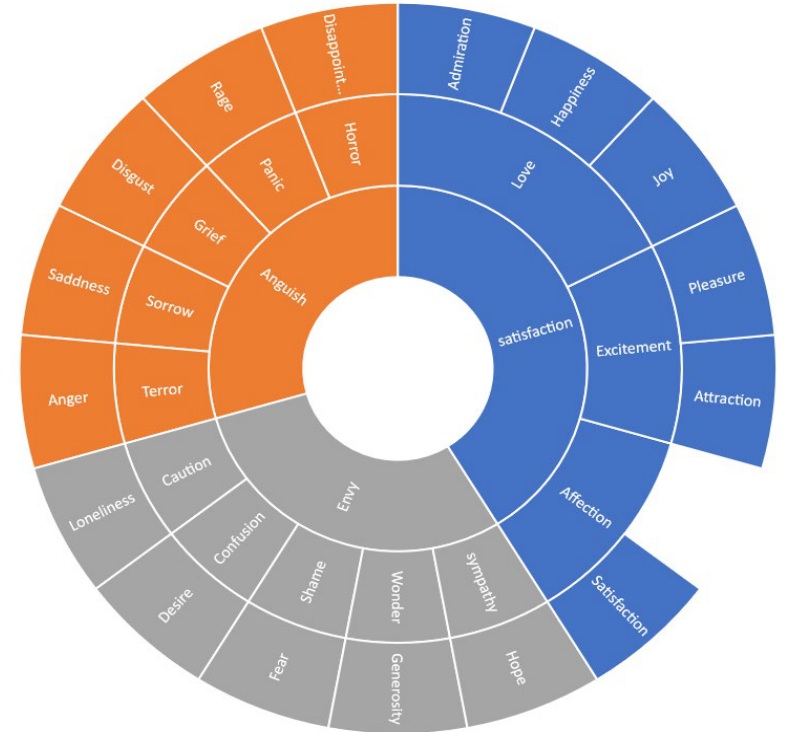
Figure 3. A representation of the wheel of emotions (the Plutchik’s model).